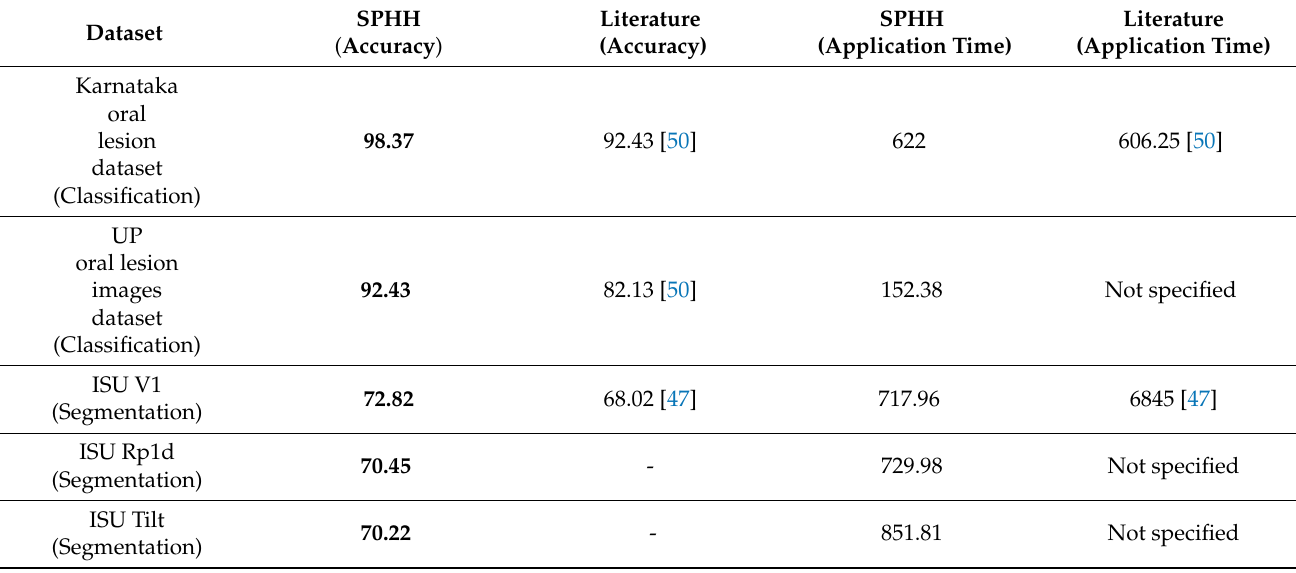
Table 8. Performance of SPHH compared with the state of the art and other deep neural network pipeline techniques for the image-processing datasets.